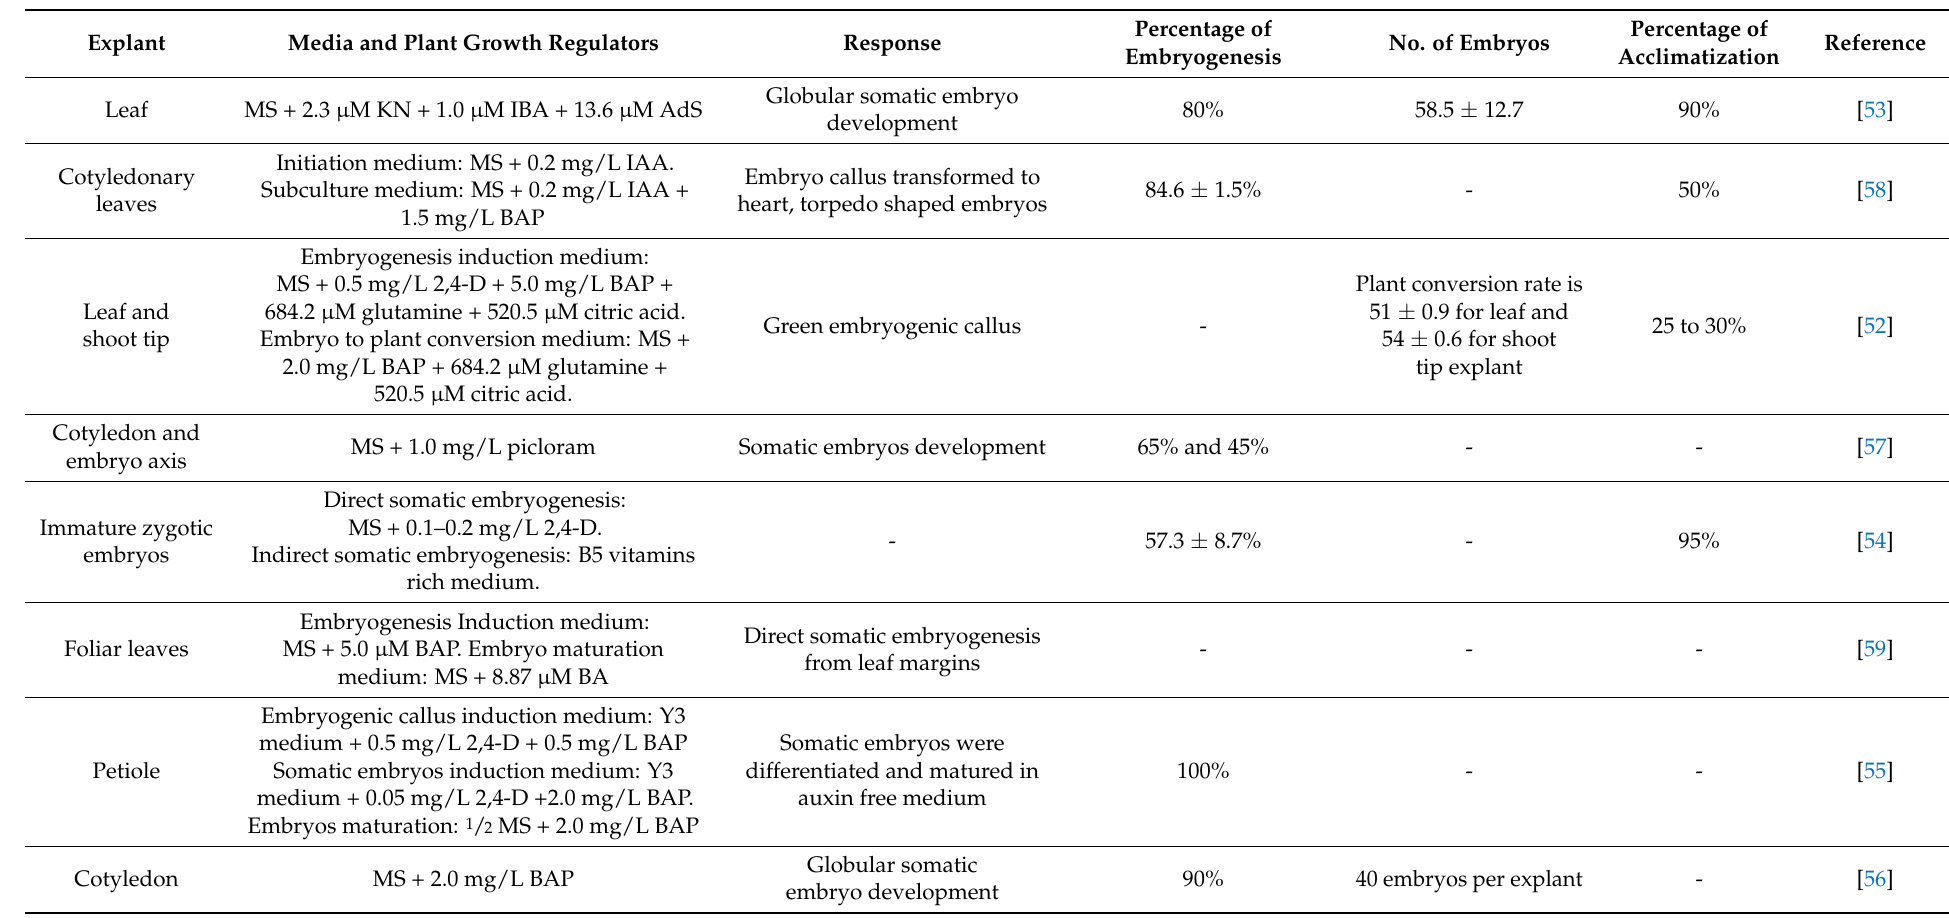
Table 3. Somatic embryogenesis from various explants of Jatropha curcas